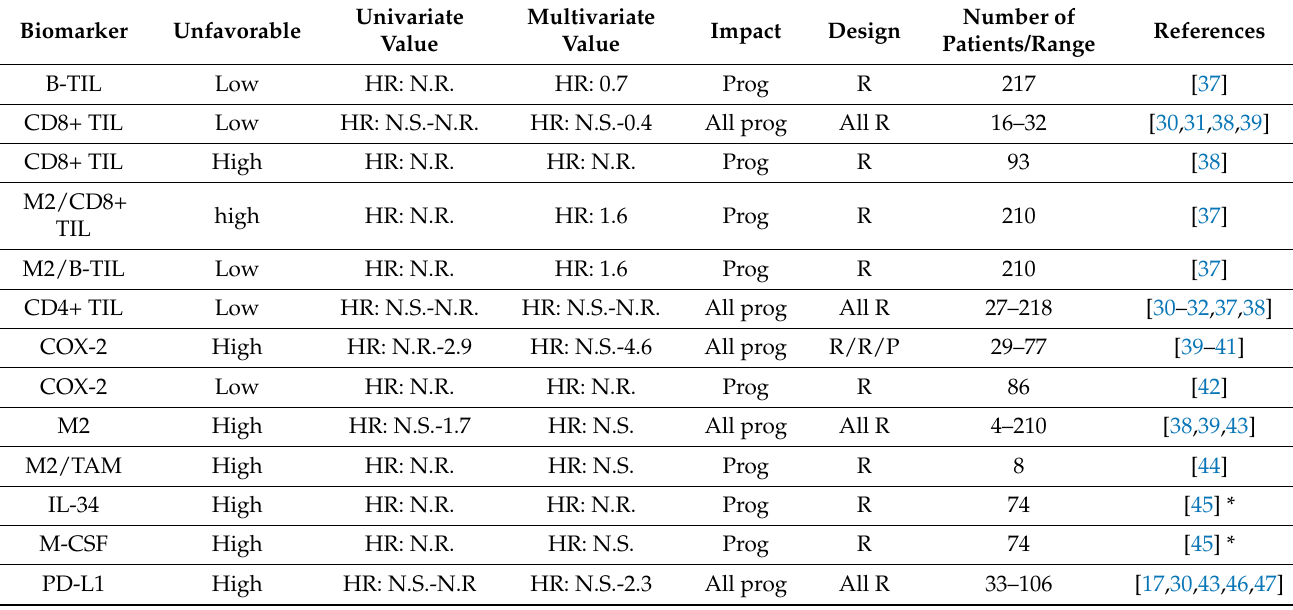
Table 1. Potential local inflammatory